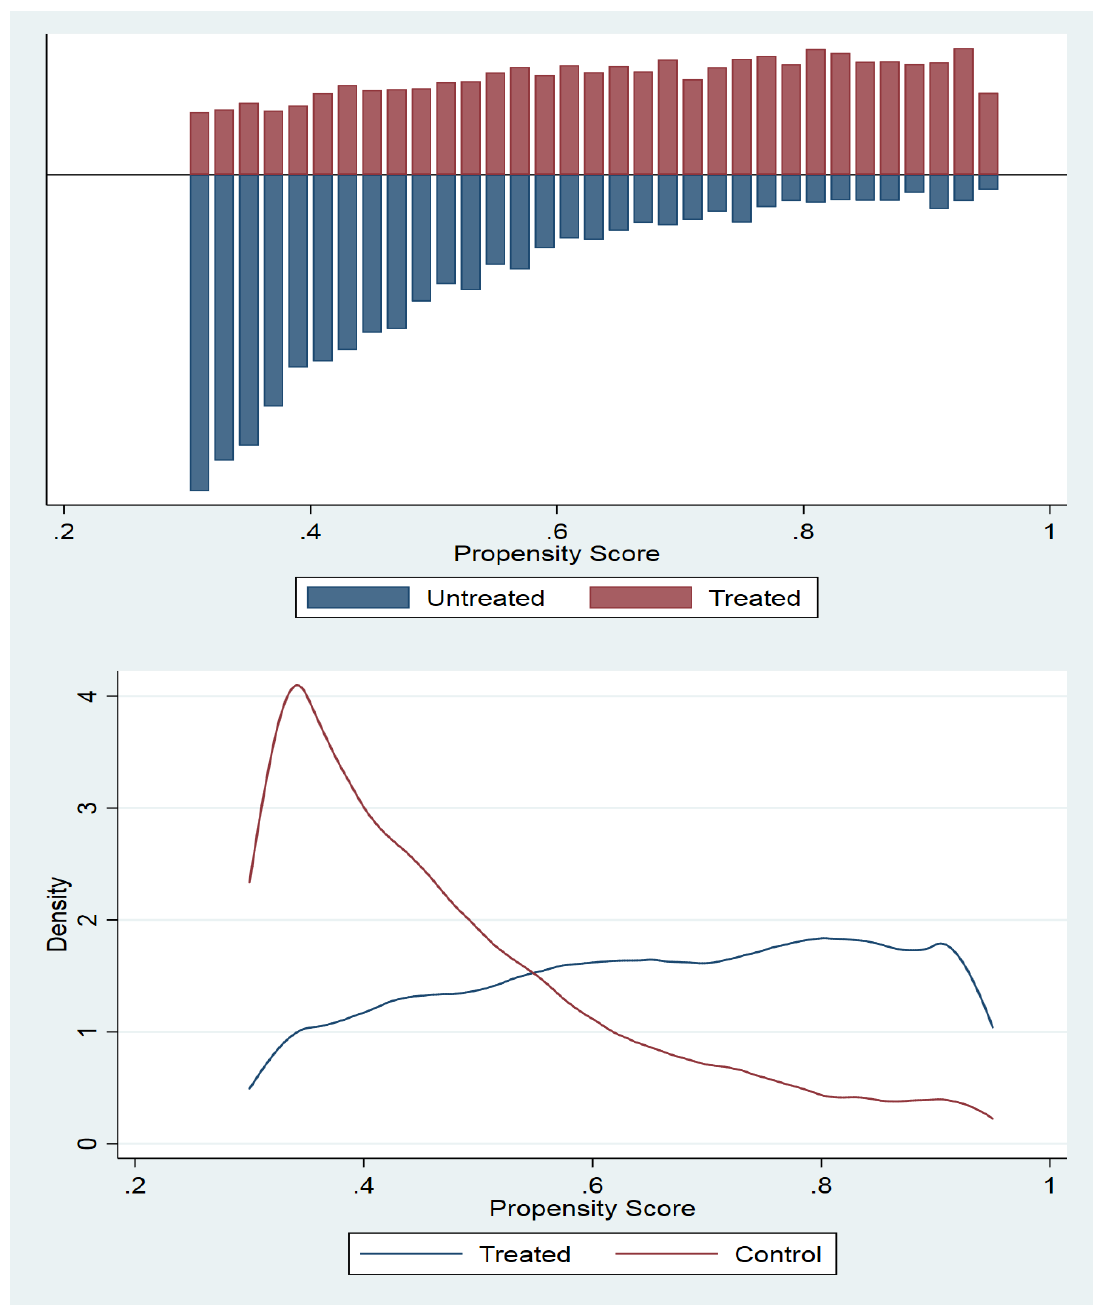
Figure A1. Propensity score distribution for purpose of common support.